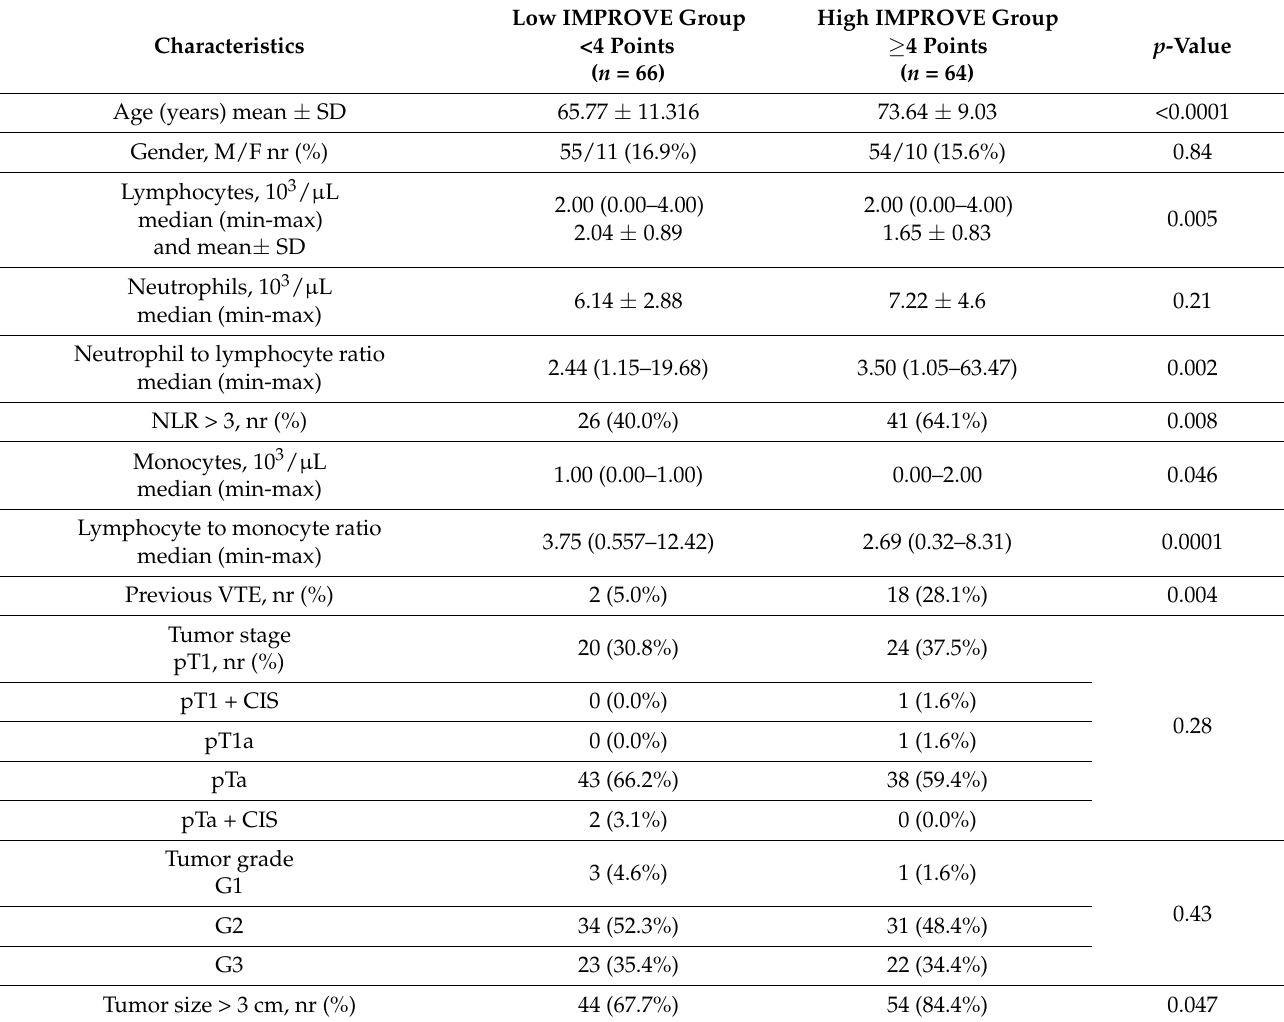
Table 1. Demographic and laboratory data of the study